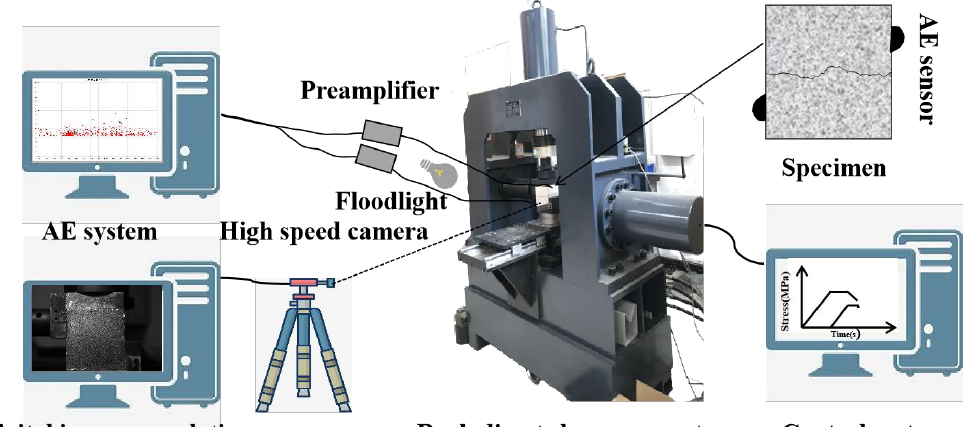
Figure 4. Test instrument.